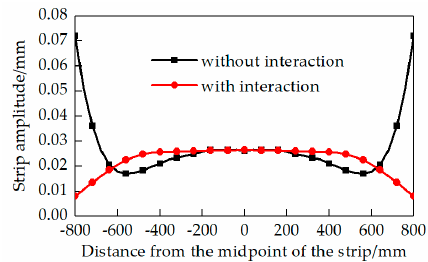
Figure 4. Strip amplitude distribution with or without fluid–structure interaction.